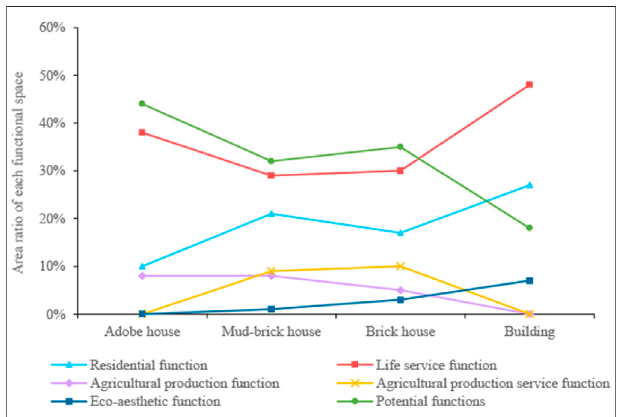
FIGURE 4 | Differences in the proportions of the functional spaces of different types of rural homesteads.